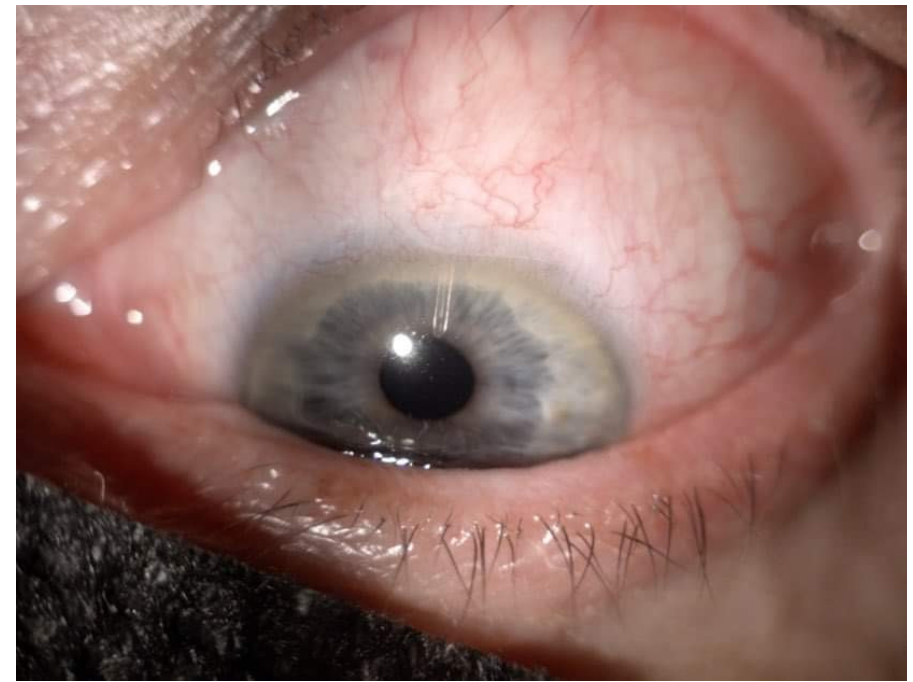
Figure 2. Preserflo Microshunt in anterior chamber.